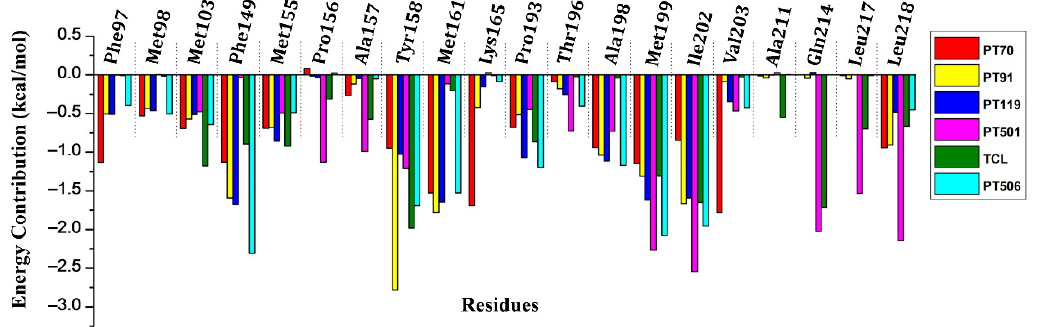
Figure 2. The energy contribution spectrum of key residues to the binding of different InhA direct inhibitors.